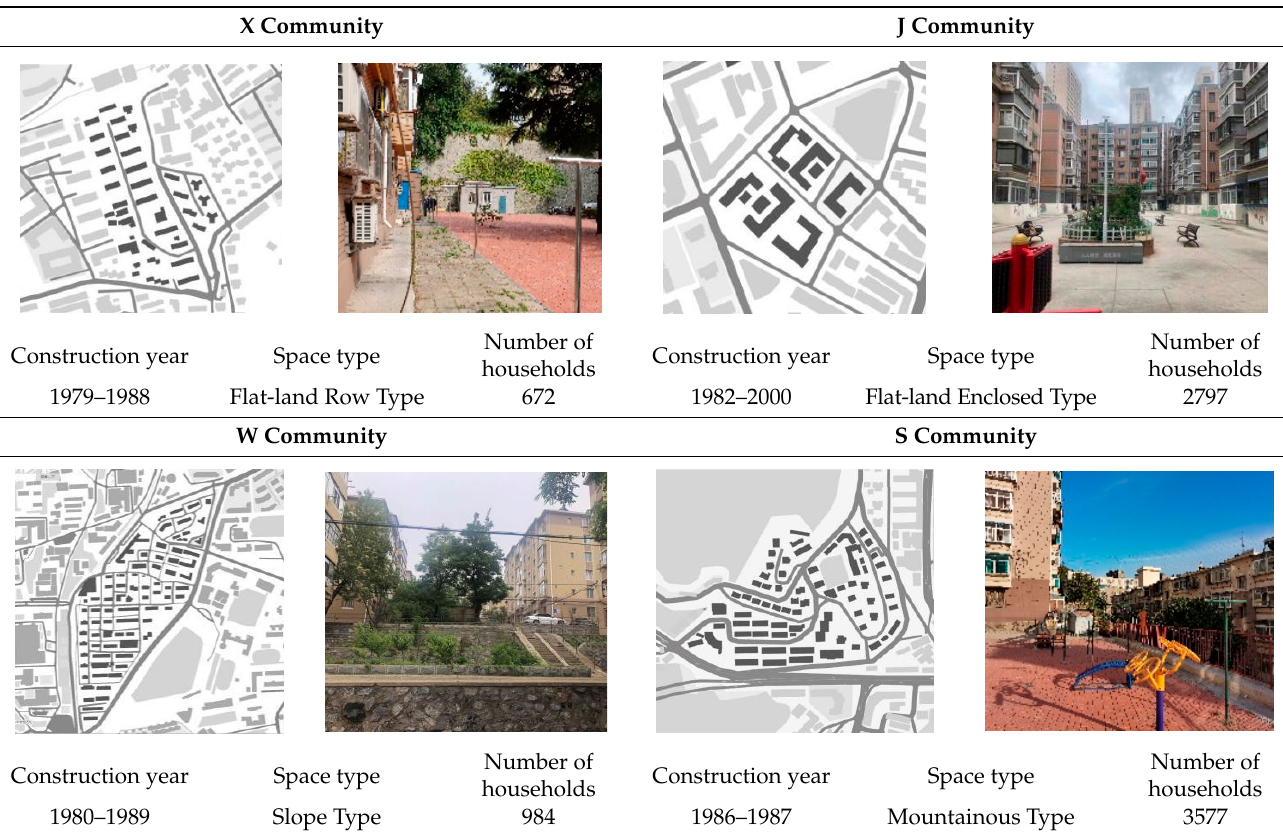
Table 2. Characteristics of residential activities of the elderly on sunny days (overlapping two-day data 8:00–18:00).